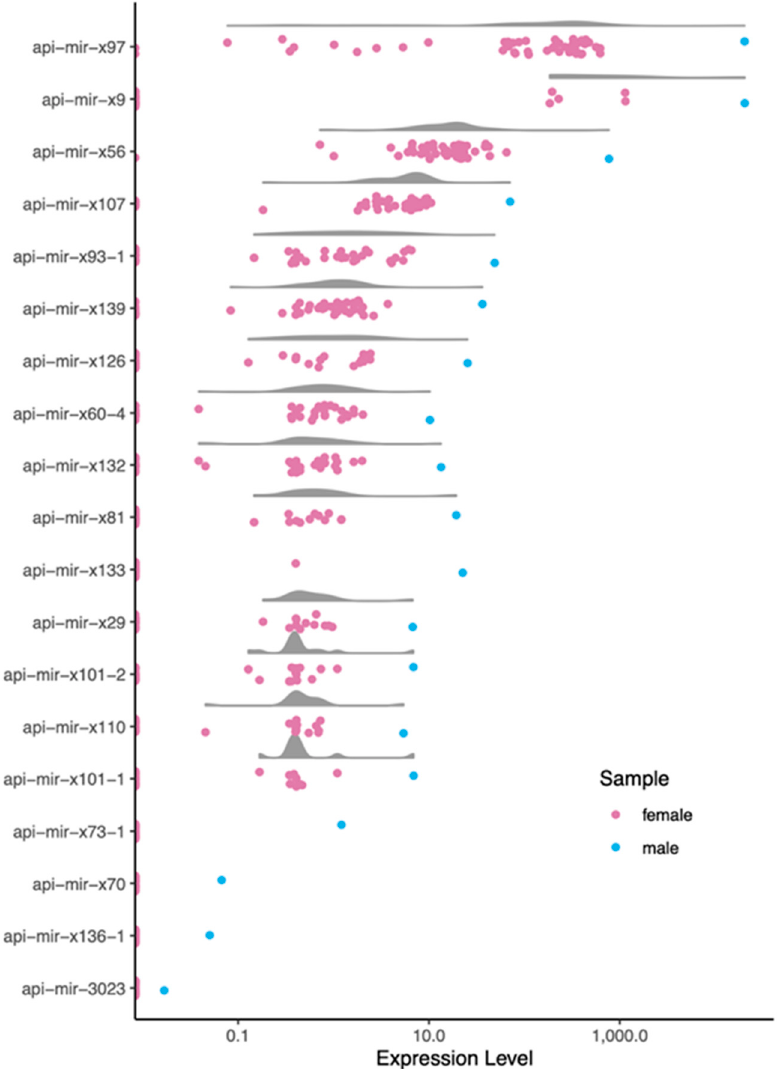
Figure 3. Expression level of male-biased miRNAs across libraries. Expression level is shown on the x -axis in terms of log (cpm). Individual data points from female (pink) or male (blue) samples are shown. A raincloud plot summarizes the expressed data points (gray cloud) but excludes the unexpressed data points (left along y -axis).